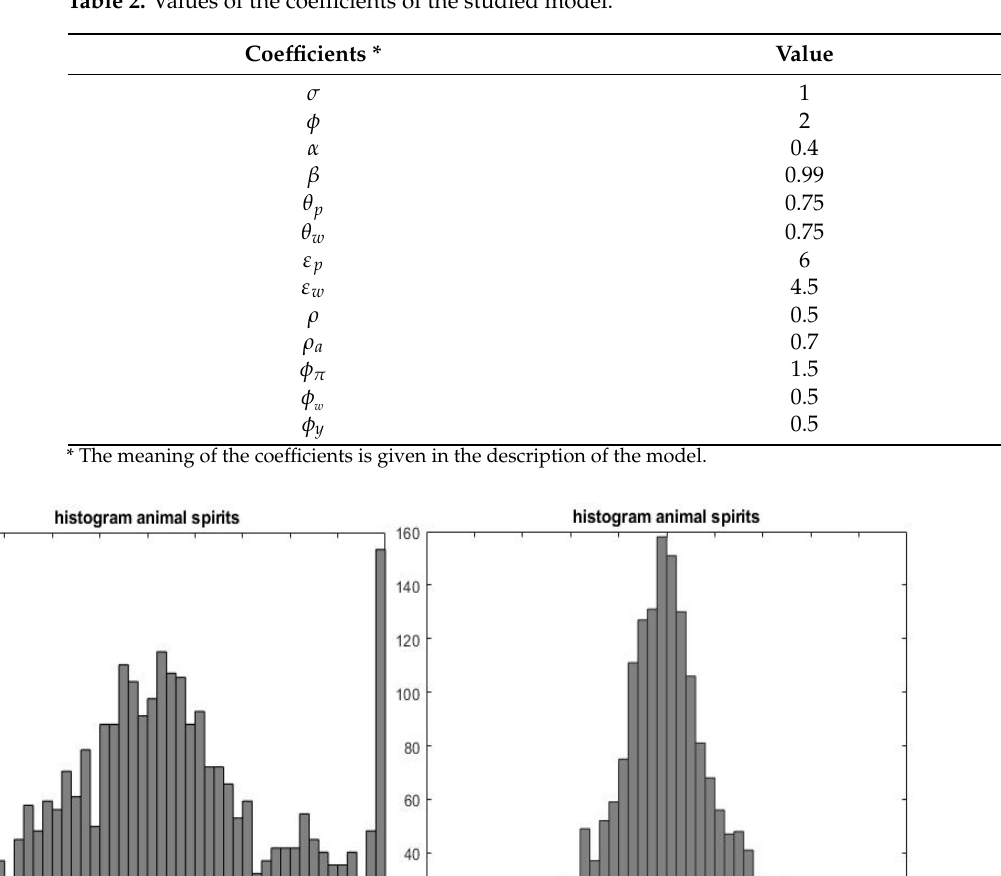
Table 2. Values of the coefficients of the studied model.